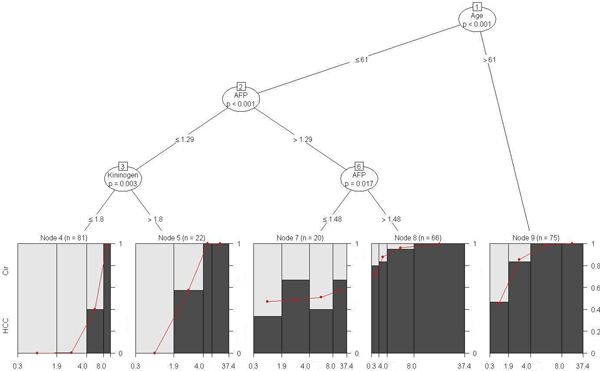
Model-based CART analysis based on the biomarker GP73 conditional on the tree analysis using AFP, AAT, Kininogen and age, after controlling for site, for the complete data set. Variables that appear in the tree were involved in a statistically significant split (based on p-value < 0.05). Any two (or more) bins that appear at the bottom child nodes in this tree sharing the same mother node represent disjoint sub-groups of patients identified by this method to be (statistically) significantly different. The sub-groups are defined by the respective cut-points for biomarker levels and age. For example, when gender effect is controlled for in the model it is evident that age alone, independent of other biomarkers, plays a significant role in the incidence of HCC (p < 0.001). The node pair (1,9) represents the sub-group of 75 patients older than 61 years that have a significantly higher incidence of HCC compared to younger patients. It provides a unique, visual representation of complex interactions between biomarkers, age and gender though gender is not found to be statistically significant in any of the interactions. In addition, this approach identifies potential cut-points for biomarker levels that are significantly associated with the incidence of HCC. A detailed interpretation of this tree is provided in the text.